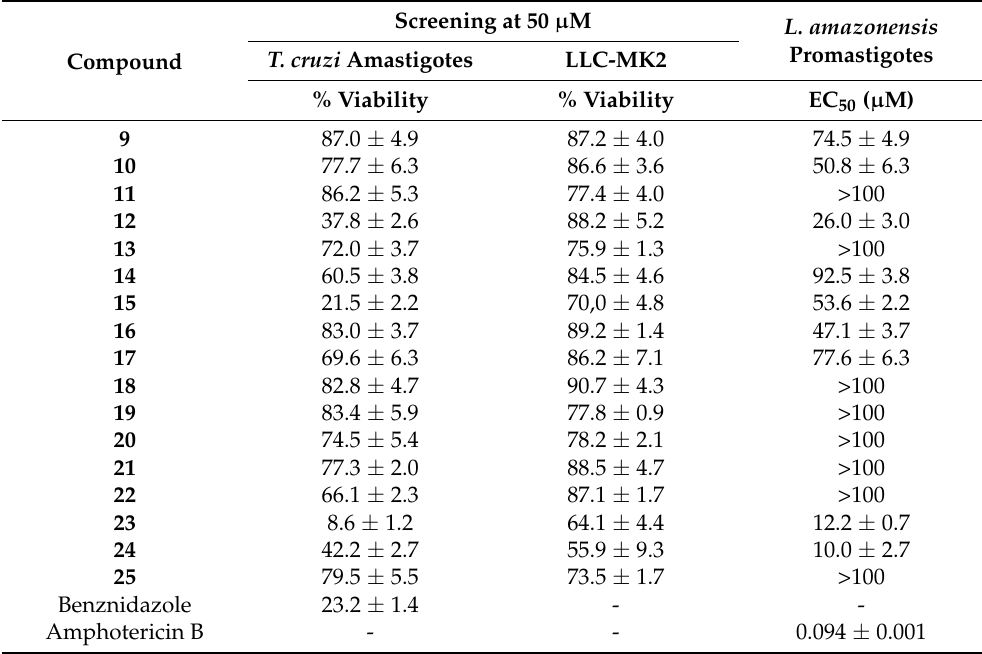
Table 3. Screening results against T. cruzi amastigotes and LLC-MK2 host cells at 50 µ M and EC 50 on L. amazonensis promastigotes.